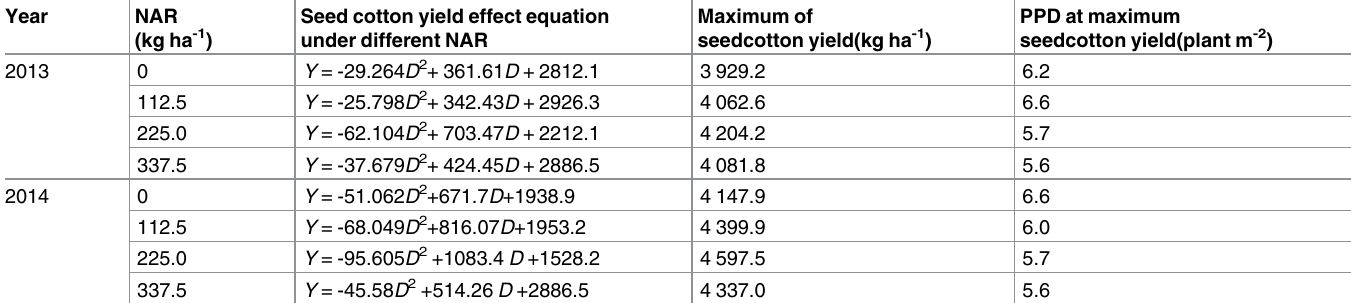
Table 4. Seedcotton yield effect equation of PPD under different NAR